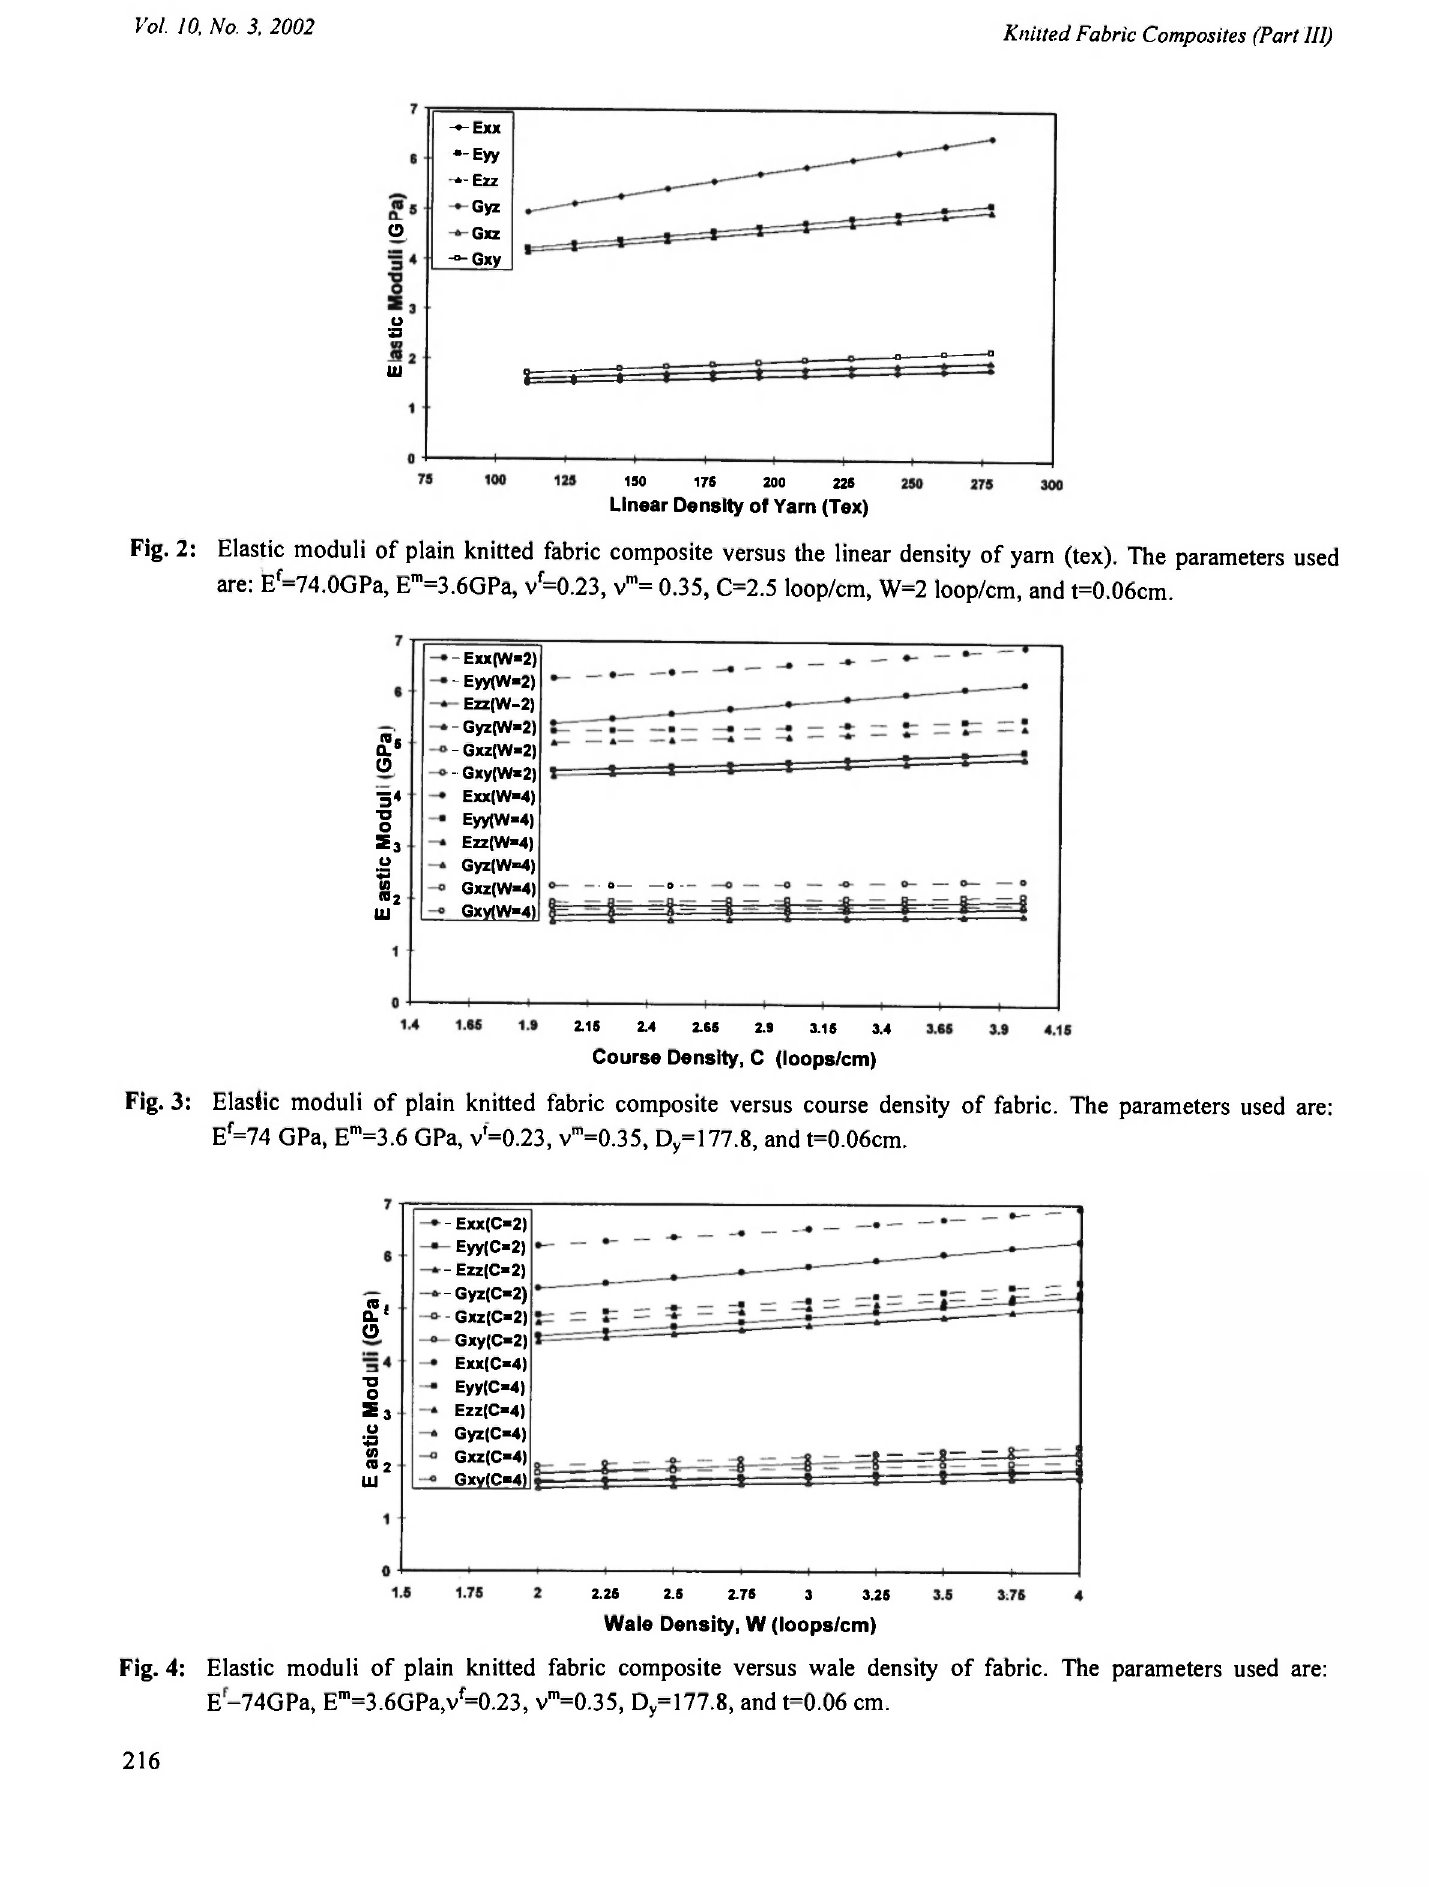
Fig. 4: Elastic moduli of plain knitted fabric composite versus wale density of fabric. The parameters used are: E-74GPa, E m =3.6GPa,v f =0.23, v m =0.35, D y =177.8, and t=0.06 cm.